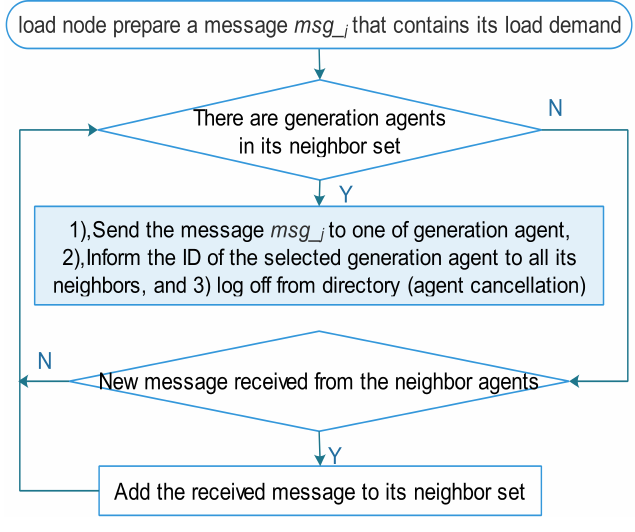
Figure 1. Life cycle of load